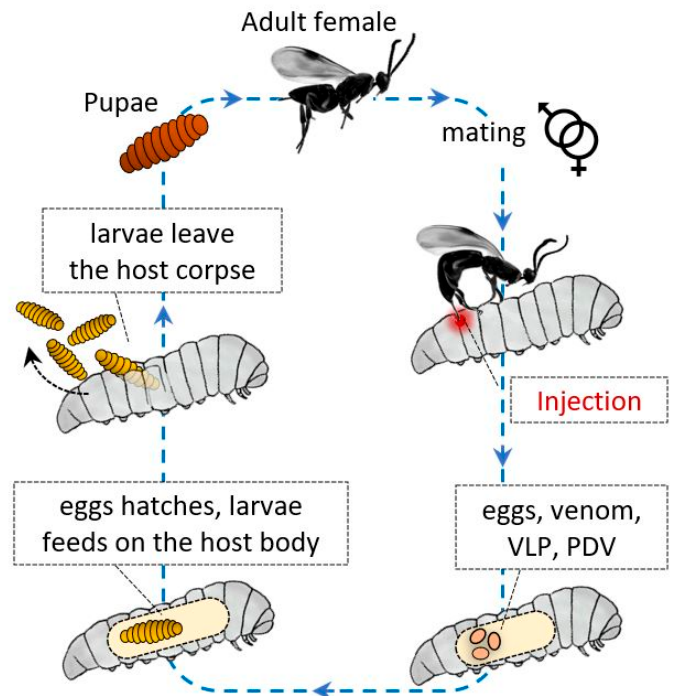
Figure 5. Some entomopathogen wasps reproduce sexually, then when they find a host, the females inject eggs into it; together with the gametes, they inject polydnavirus (PDV), virus-like particles (VLPs), and venom compounds. The compounds and viruses help the egg to not be recognized by the host immune system. In this manner, the eggs can hatch, and the larvae can develop undisturbed by feeding on the corpse of the parasitized insect.